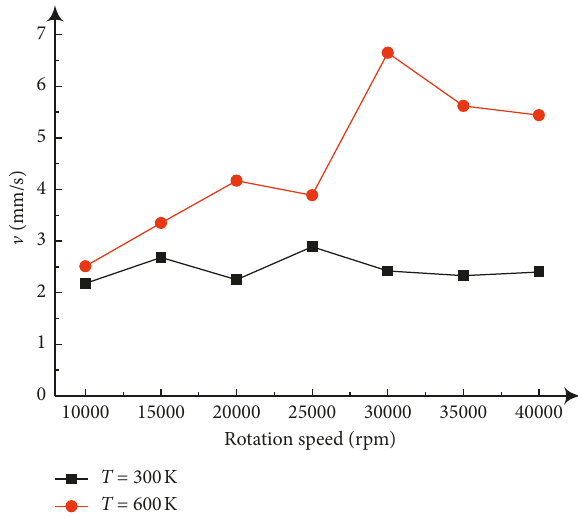
Figure 13: Trends of outer ring vibration with rotation